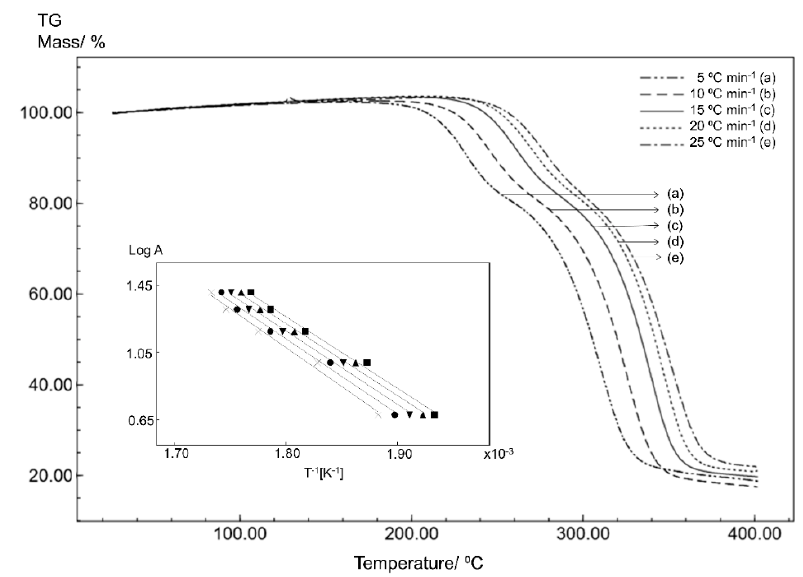
Figure 10. TG curves for STGB obtained for different heating rates with a synthetic air atmosphere (50 mL min − 1 ). The inset shows the linear tendency of the correlation curves obtained applying the Ozawa method.